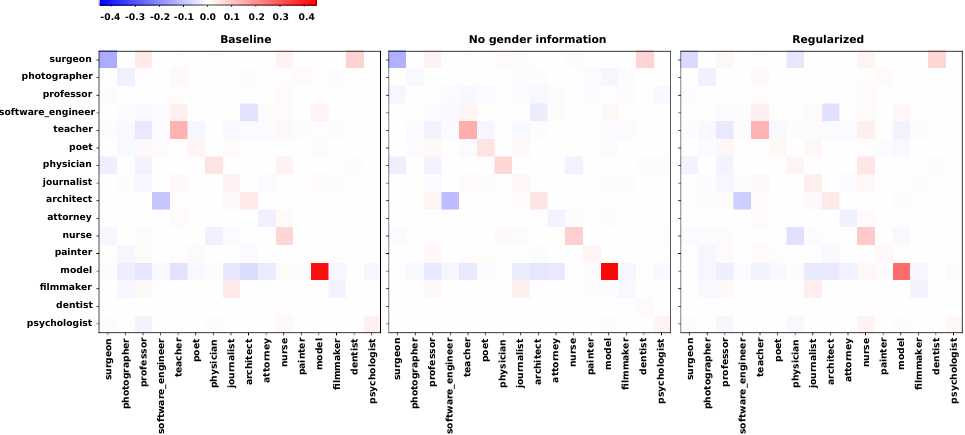
Figure 2. Average difference between the confusion matrices of the predicted outputs ˆ y versus the true outputs y obtained for females and males. Note that the diagonal values of these matrices correspond to the average TPR gaps. The confusion matrices were also normalised over the true (rows) conditions. The redder a value, the stronger the bias in favour of females is, and the bluer a value, the stronger the bias in favour of males